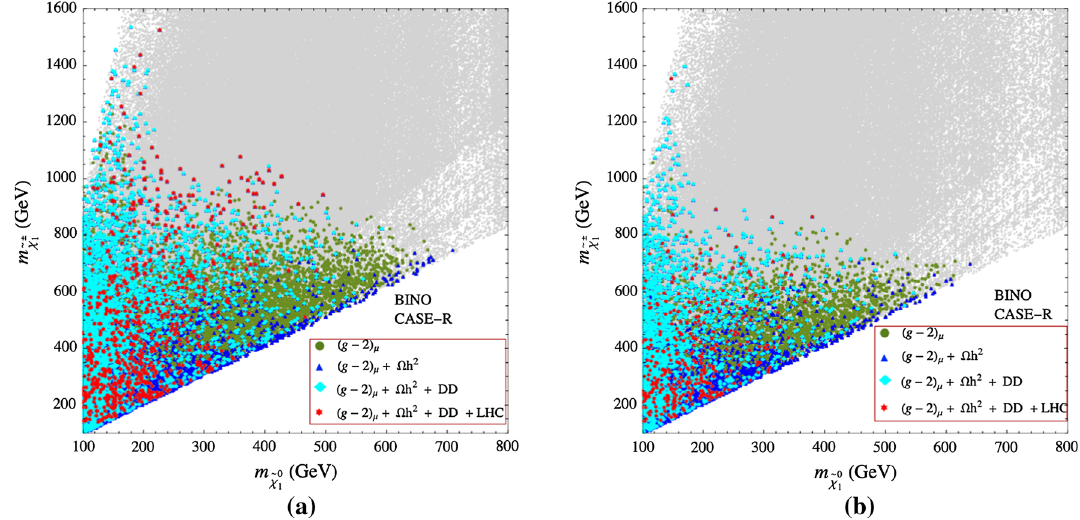
− m plane for the ˜ l -coannihilation case-R scenario for current (left) and anticipated future ˜ χ ± 1 1